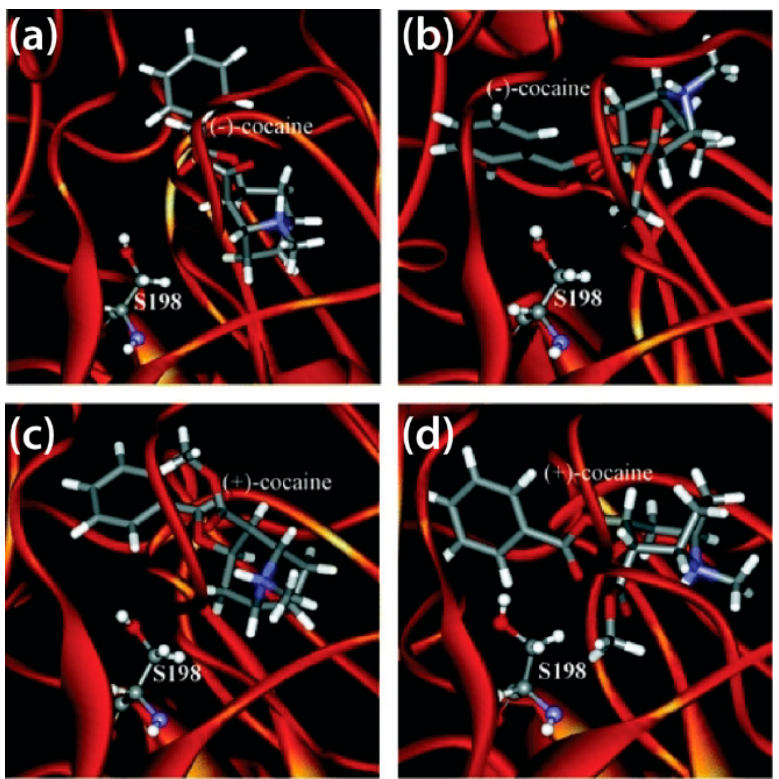
Figure 5. Wild-type BChE bound to ( a ) ( − )-cocaine in a non-prereactive complex, ( b ) ( − )-cocaine in a prereactive complex, ( c ) (+)-cocaine in a non-prereactive complex, and ( d ) (+)-cocaine prereactive complex [138].